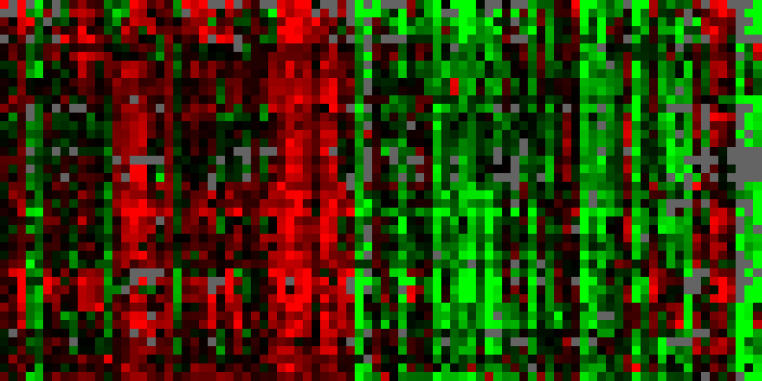
A group of renal cell carcinomas share similar expression patterns